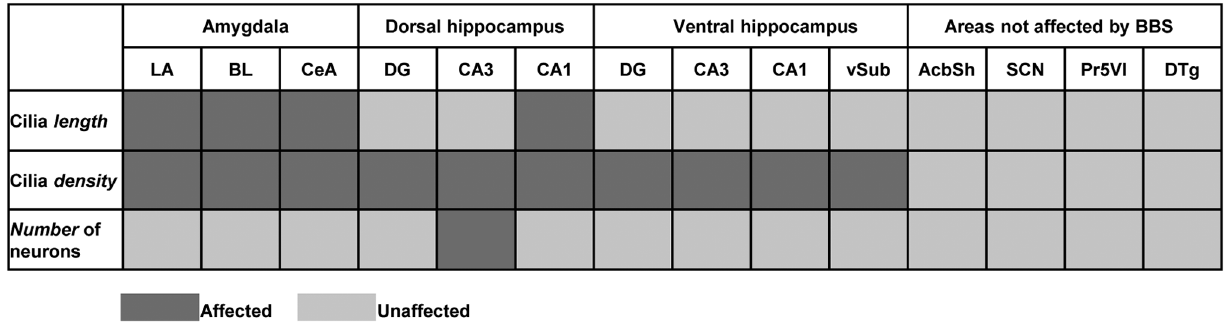
Figure 11. Variable ciliopathy phenotype in the investigated brain regions. Dark grey rectangle corresponds to the regions where ether the PNC or the number of neurons are affected in Bbs4 -/- mice brains. Light gray rectangle corresponds to the unaffected areas. Abbreviations as for Figures 1, 4 & 7.